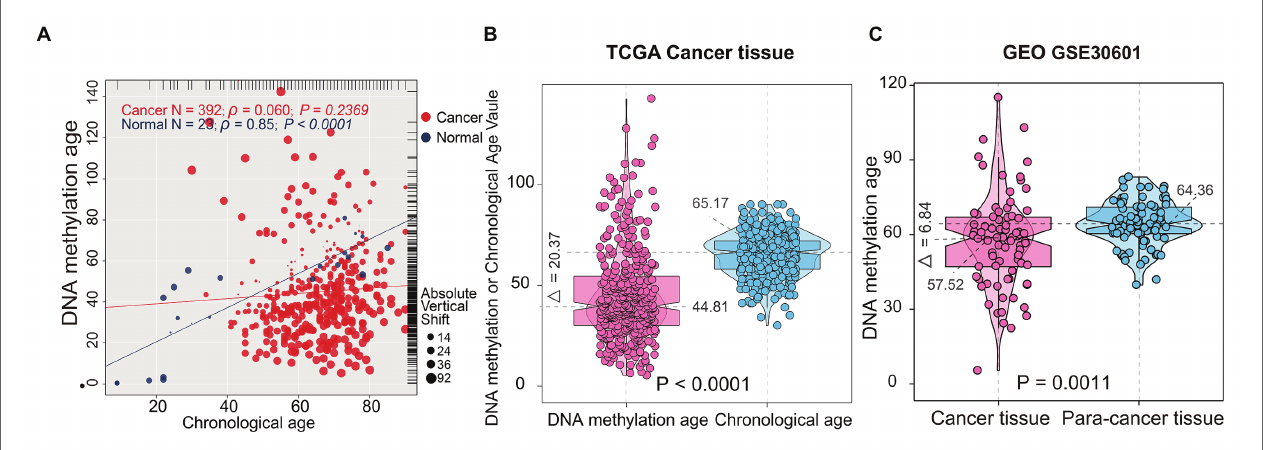
FIGURE 2 | Correlations between DNAm age and chronological age (CA) in stomach tissues. (A) Correlations between DNAm age and CA in normal gastric and STAD samples; (B) DNAm age was significantly lower than CA in TCGA STAD samples. (C) Tumor adjacent normal tissues presented with significantly higher DNAm age than cancer tissues. The test for association between gastric samples used Pearson’s correlation coefficient. Two-tailed statistical p values were calculated by a paired samples t -test. STAD, stomach adenocarcinoma; TCGA, The Cancer Genome